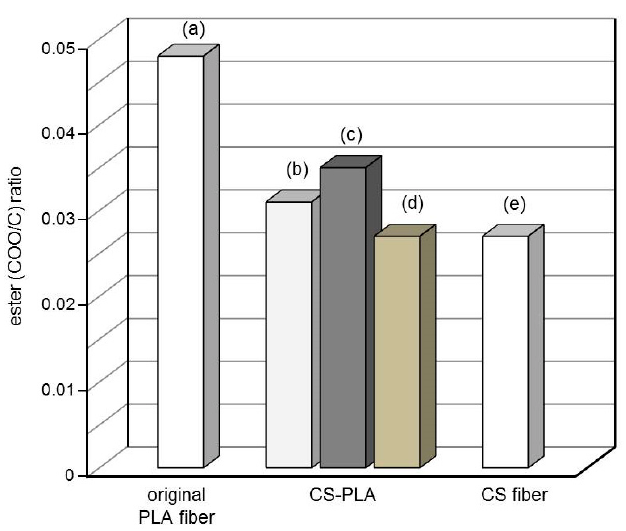
Figure 5. Ester (COO/C) ratio of fibers from XPS analysis: ( a ) original PLA fiber; ( b ) P-3; ( c ) P-4; ( d ) P-5 and ( e ) CS fiber.